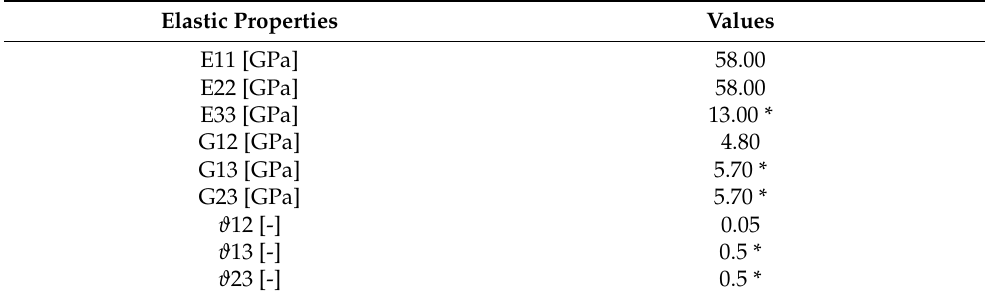
Table 1. The elastic constants for the orthotropic model used in ANSYS software for the modal analysis of CF/PEKK